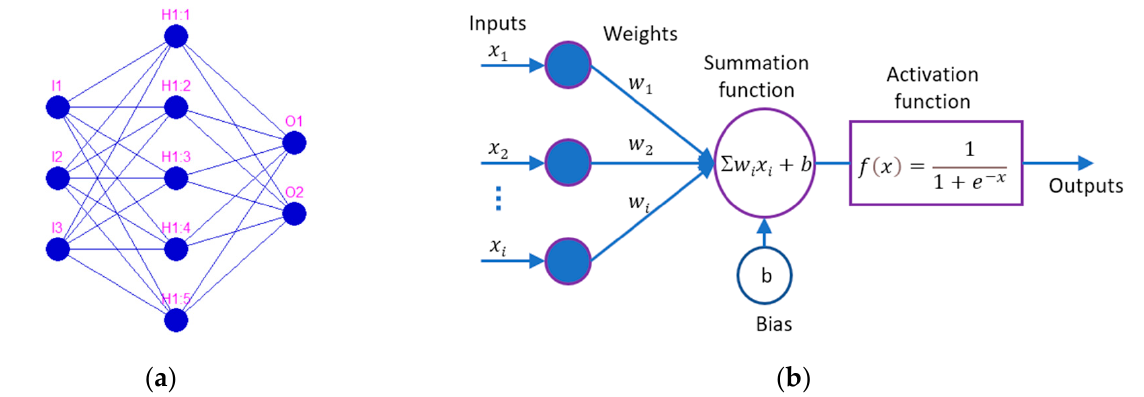
Figure 7. Artificial neural network (ANN): ( a ) ANN—general architecture; ( b ) mathematical representation of an artificial neuron.